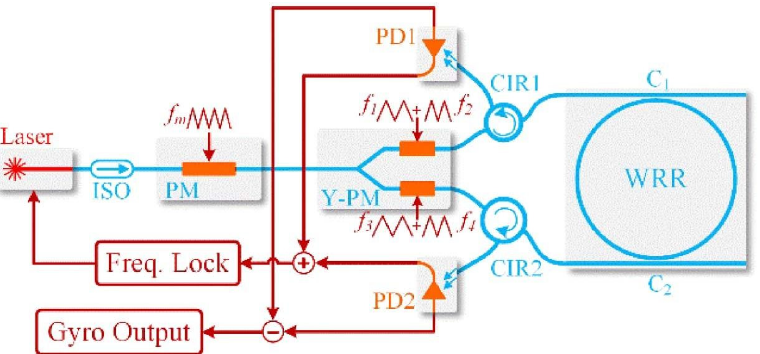
Figure 9. Schematic diagram of the RIOG with EDDT. Y-PM: Y-branch phase modulator; CIR: circulator. Reprinted with permission from ref. [27]. Copyright 2018 The Optical